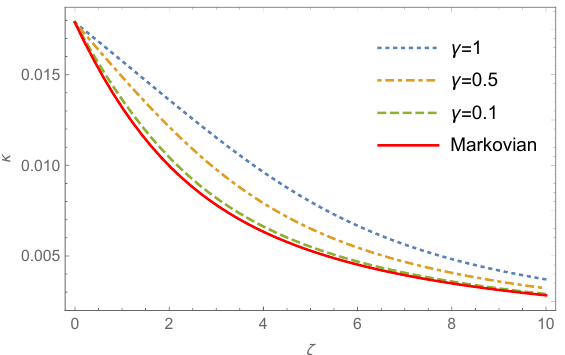
Figure 3 . The dependence of the transition rate of the Hawking-Page phase transition from the large SAdS black hole state to the thermal AdS state on the friction coefficient ζ for the exponentially decayed friction kernel. In the plot, L = 1 , and T = 0 . 5 .